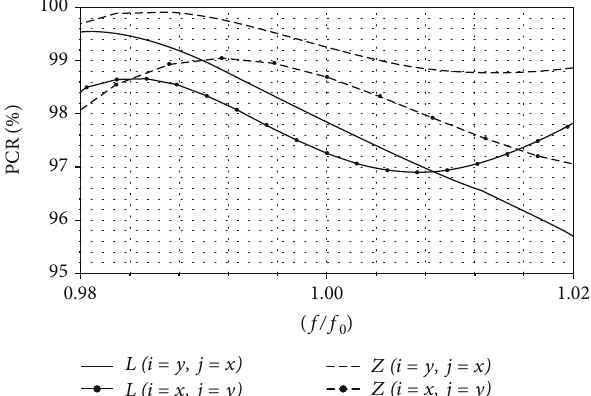
Figure 9: The computed PCR of L - and Z -shaped LP